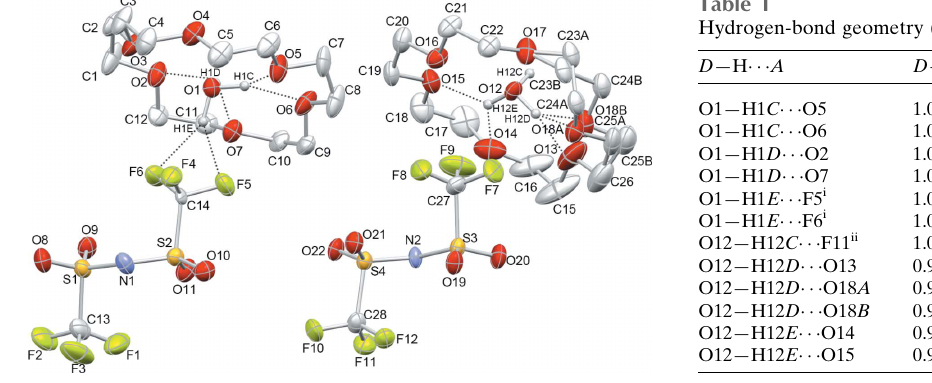
Figure 1 The asymmetric unit of the title compound, showing the two crystal- lographically independent ion-pairs. Displacement ellipsoids are shown at the 50% probability level and hydrogen atoms of 18-crown-6 are omitted for clarity. Dashed lines represent hydrogen